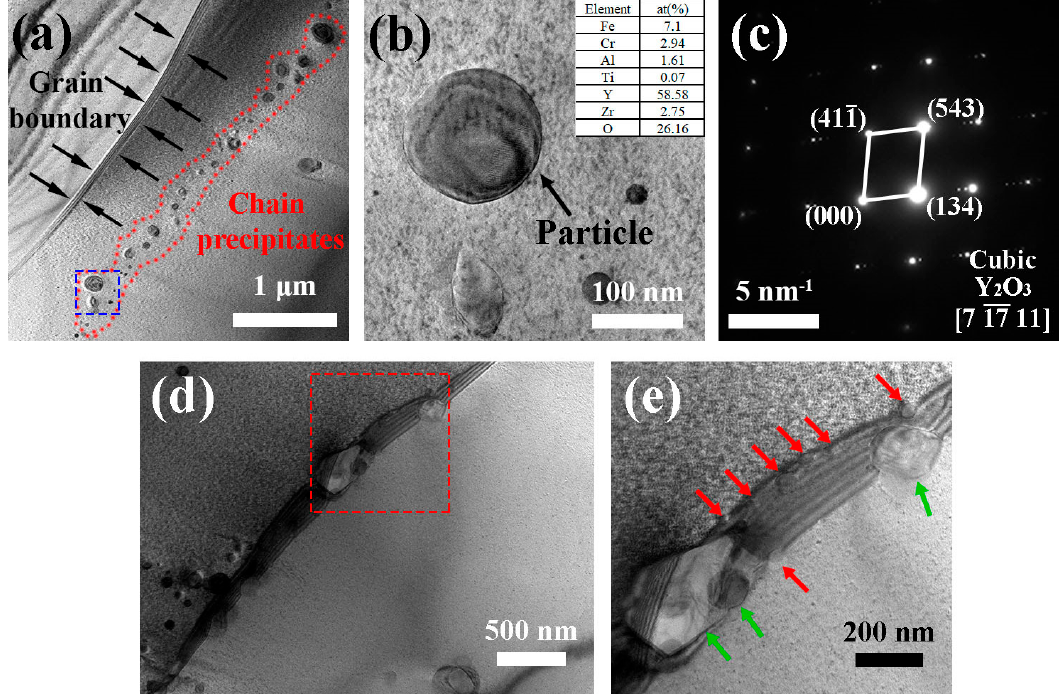
Figure 5. ( a ) TEM bright field image of continuous precipitates near the grain boundary in the as-HIPed alloy B; ( b ) high magnification of the area inside the dashed blue line in ( a ); ( c ) SAD pattern for the arrowed particle in ( b ); ( d ) TEM bright field image of the precipitates at the grain boundary; ( e ) high magnification of the area inside the dashed red line in ( d ); grain boundary precipitates of different sizes are pointed by red and green arrows.